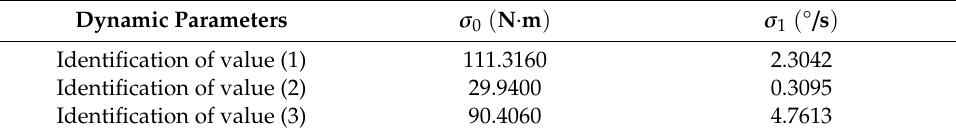
Table 2. Dynamic parameters of the LuGre friction